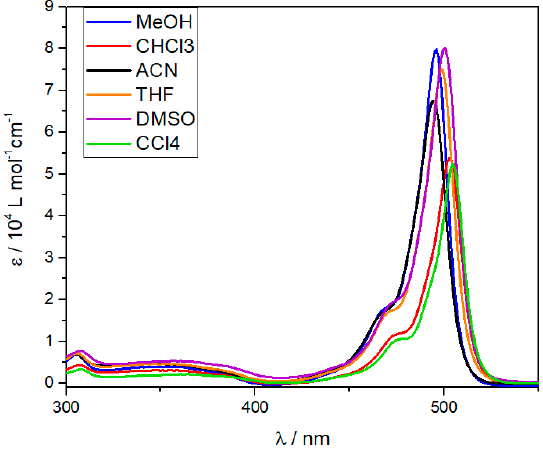
Figure 1. Solvent-dependent UV/Vis studies of compound 1 (c = 1 × 10 − 5 M, 298 K). Table 2. Photophysical properties of compound 1 in different solvents. ( c = 1 x 10 -5 M, 298 K, λ exc = 460 nm).